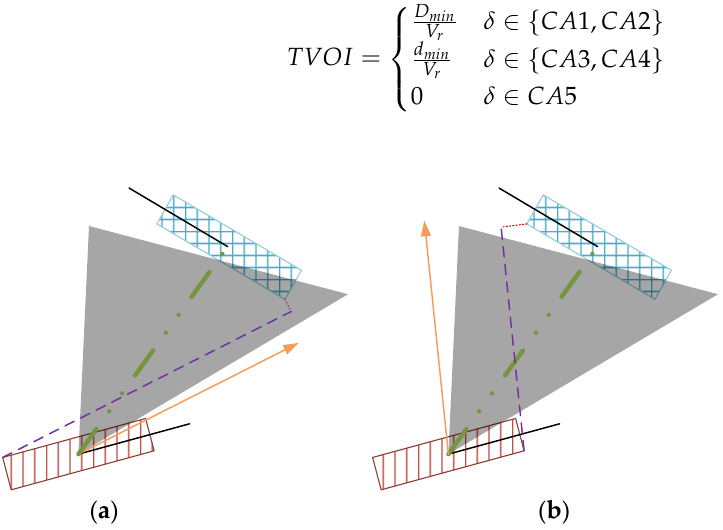
Figure 8. Time to the nearest point. ( a ) From the stern of the target ship to the closest point. ( b ) From the bow of the target ship to the closest point.